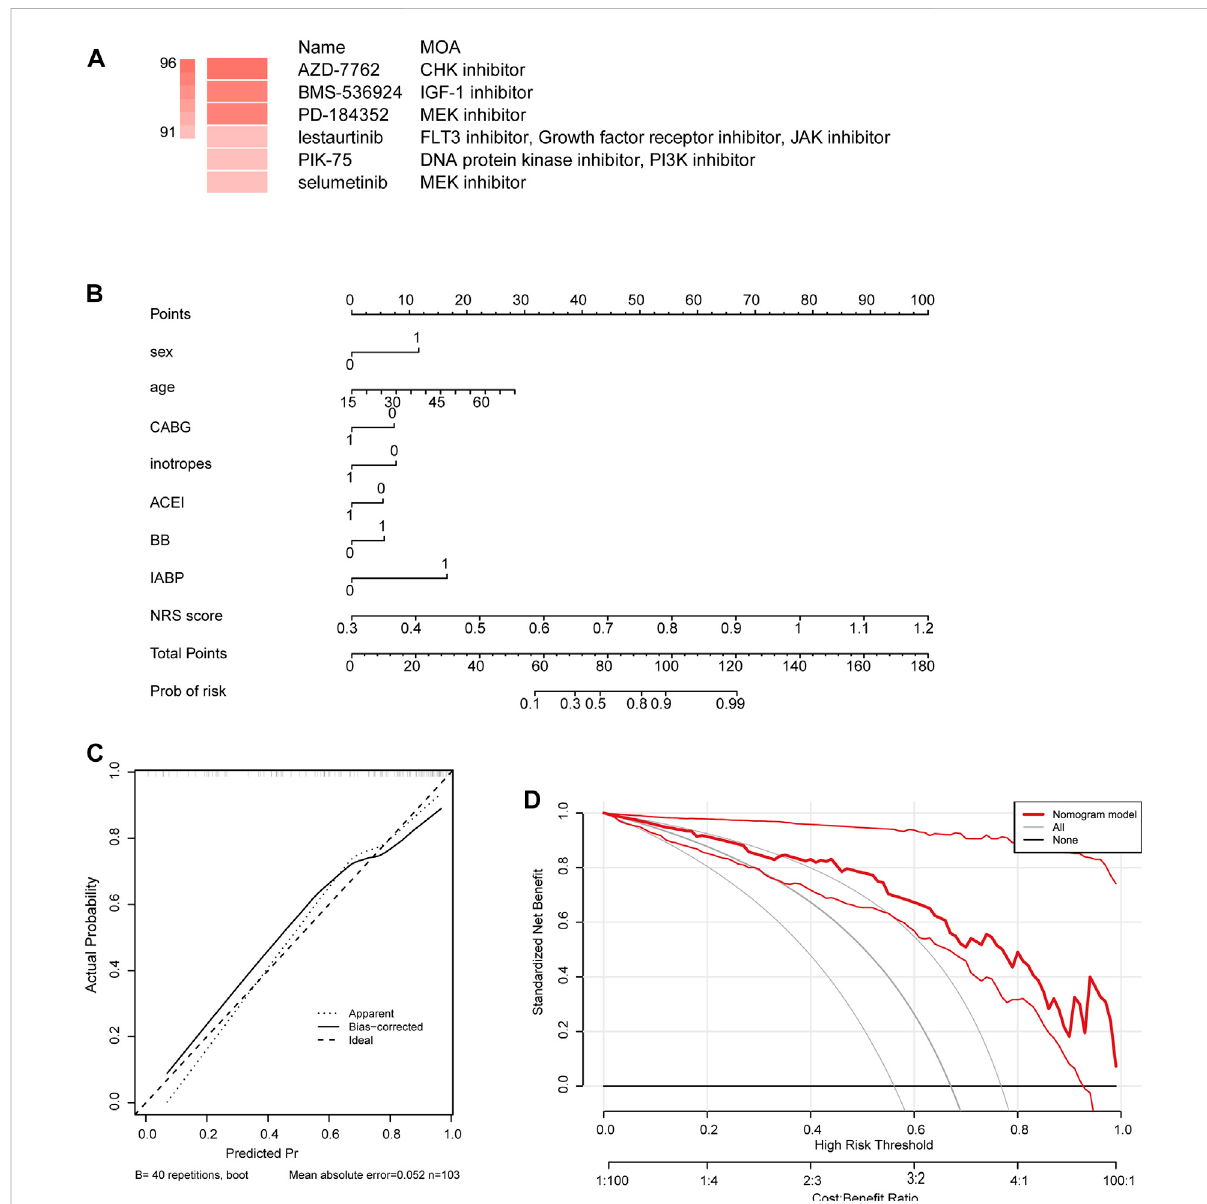
FIGURE 6 (A) Potentialanti-ICMsmallmoleculecompoundswerepredictedbyCMapanalysis. (B) Establishmentofanomogramintegratingcharacteristic genes for predicting ICM. In the nomogram, each variable corresponds to a score, and the total score can be calculated by adding the scores for all variables. (C) Calibration curve estimates the prediction accuracy of the nomogram. (D) Decision curve analysis shows the clinical bene fi t of the